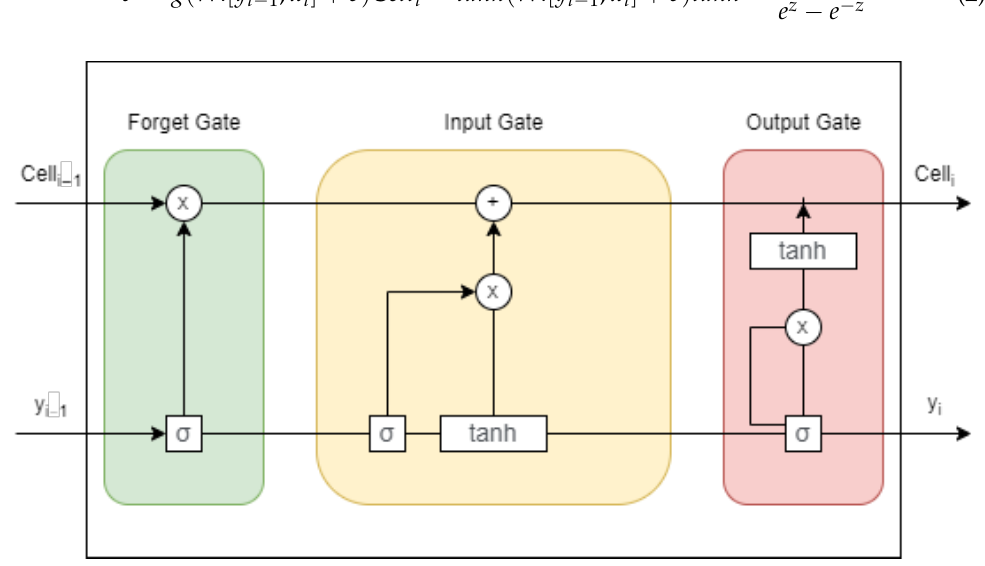
Figure 5. Overview of the LSTM cell architecture [54] illustrating the flow of input (x), output (y), and activation function ( α ) at the forget, input, and output